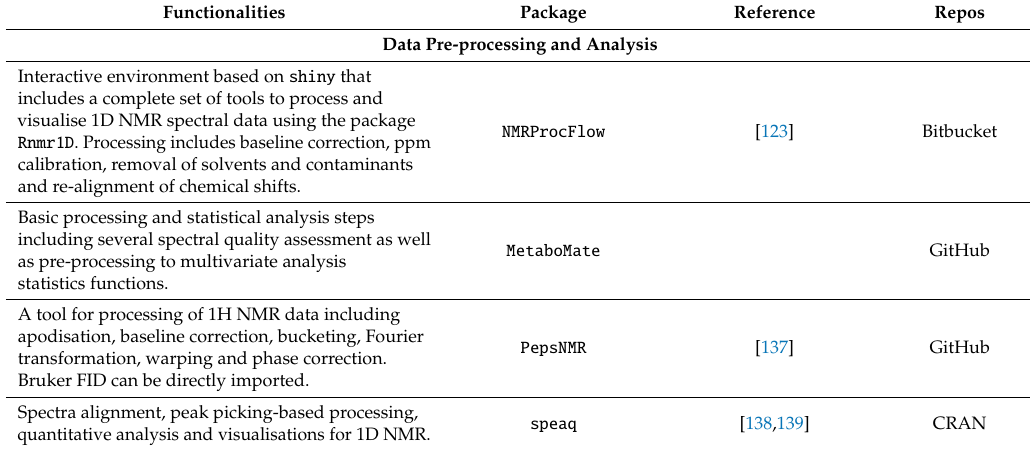
Table 4. R packages for NMR data handling, (pre-)processing and